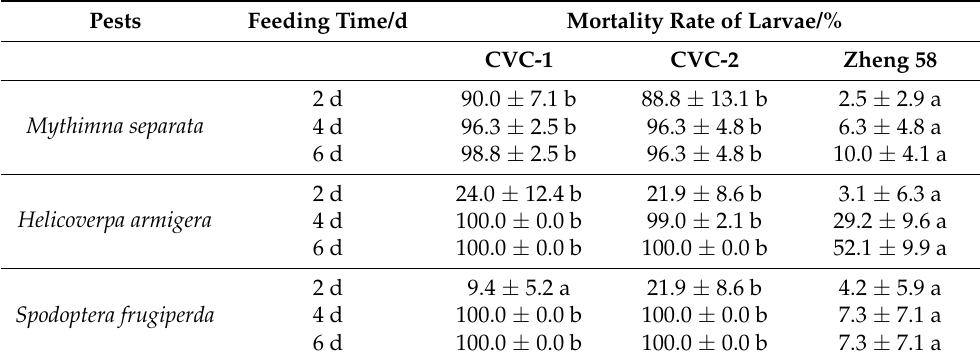
Table 1. Mortality rates of Mythimna separata , Helicoverpa armigera , and Spodoptera frugiperda larvae after feeding on transgenic and non-transgenic control maize leaves